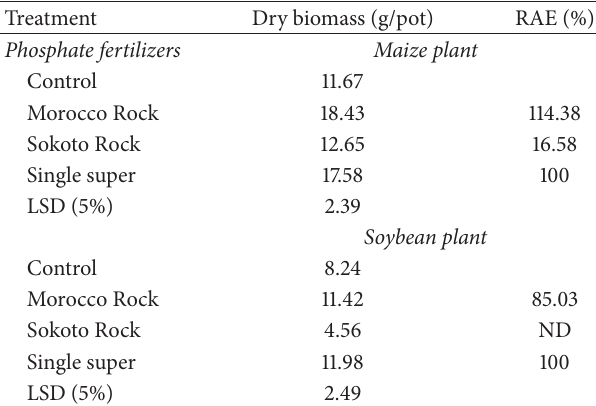
Table 3: Influence of P-sources on heights (cm) of maize and soy- bean plants (at successive growth periods) in the first cropping.